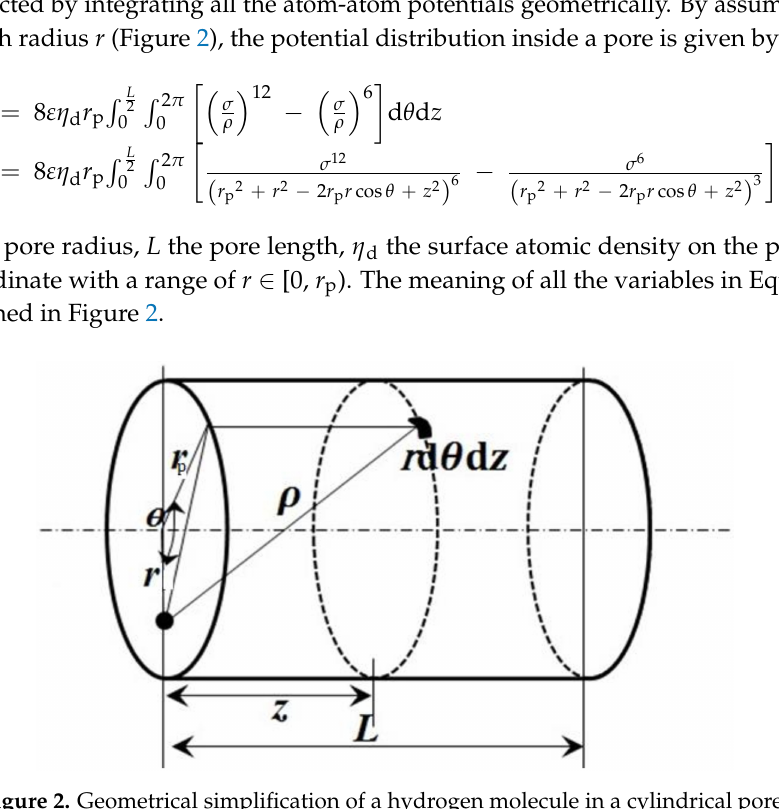
Figure 2. Geometrical simplification of a hydrogen molecule in a cylindrical pore.